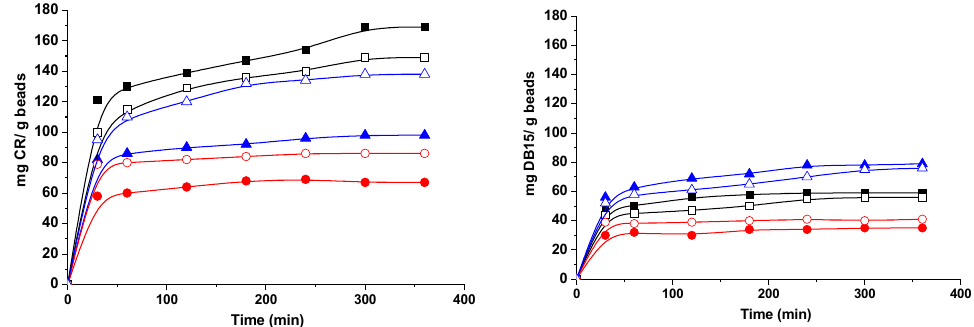
Figure 10. Sorption of dyes onto composite beads based on PS (square), WS (circle) and RS (triangle) and using CS/SgAx (close symbols) or CS/SgAN-Ax (open symbols) hydrogel beads. Thus, PS-based hydrogel beads show the best affinity to CR, whereas for DB1, better results were obtained with RS-based hydrogel beads and lower values were found when